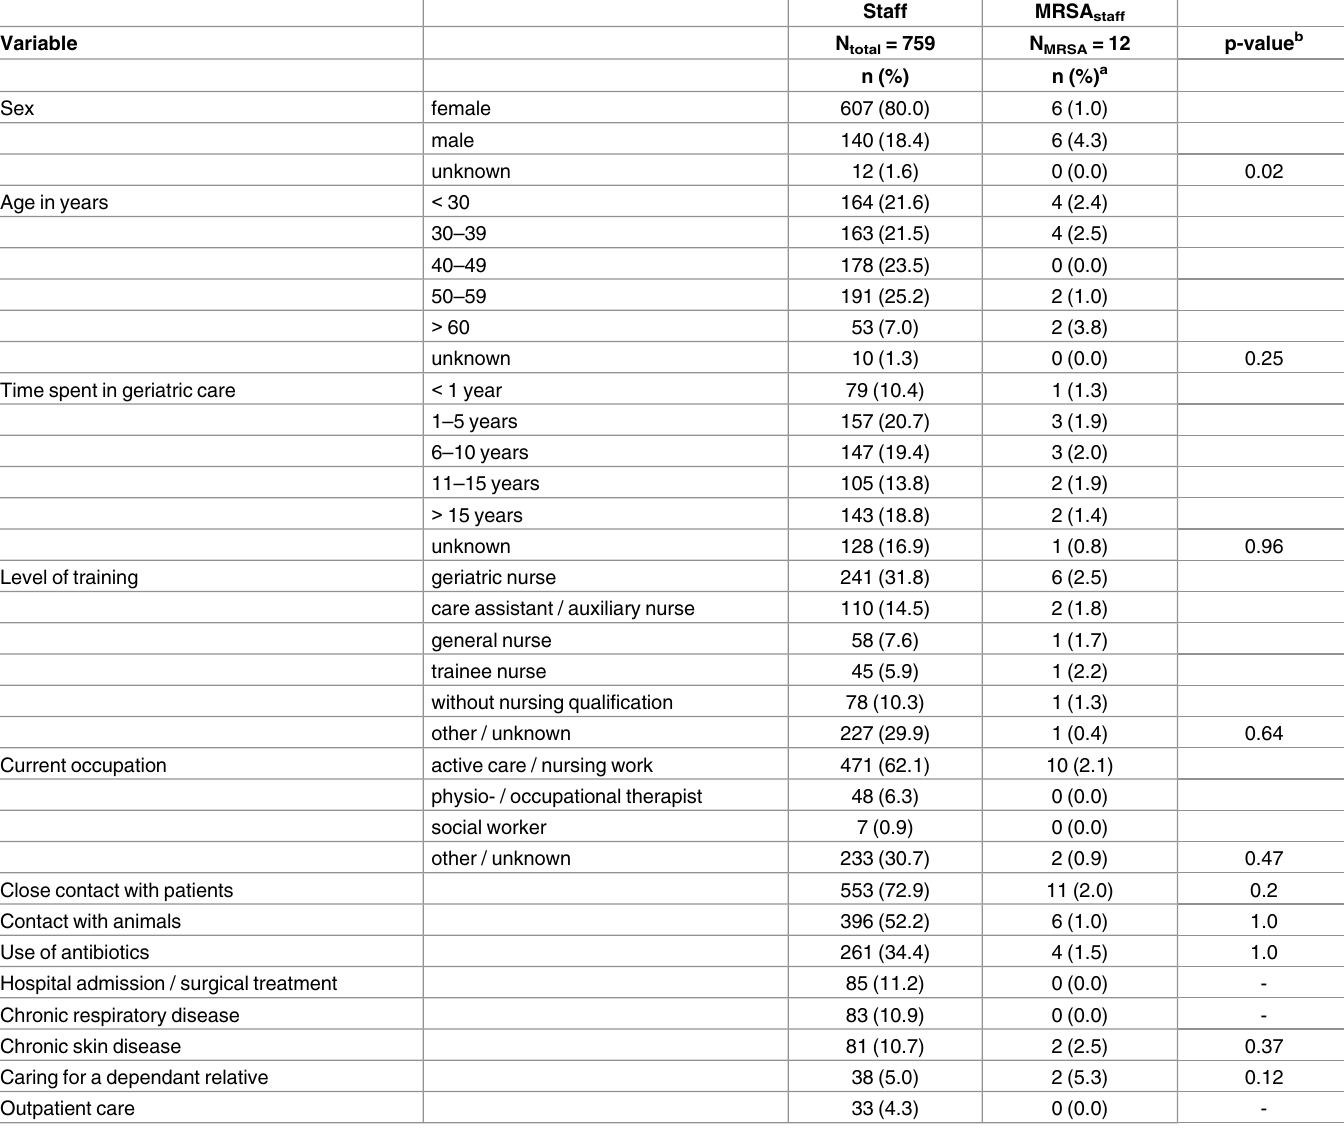
Table 1. Description of study population (staff) and MRSA-positive cases (MRSA staff ) among health